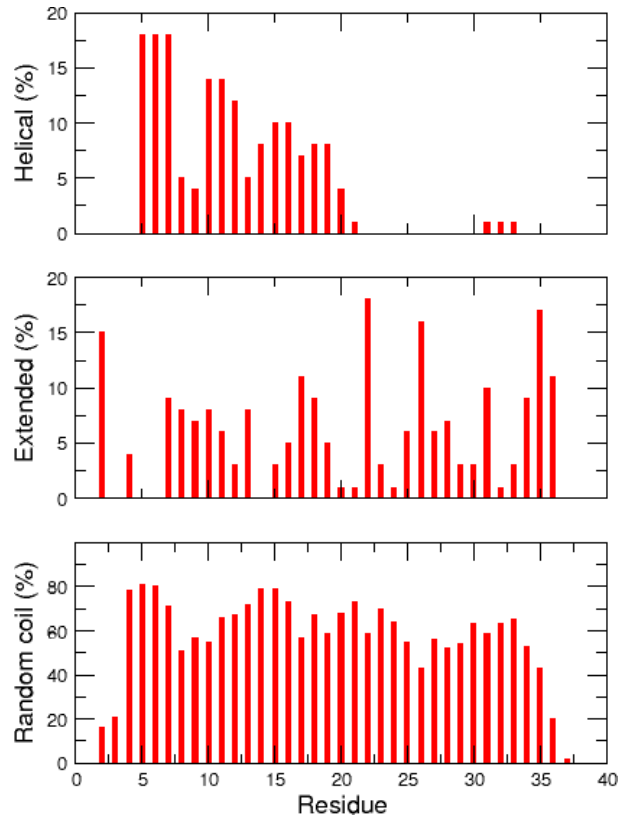
Figure 7. Percentage over the REMD trajectories of helical ( top ); extended ( middle ) and coil ( bottom ) secondary structures for each residue of the non-amidated